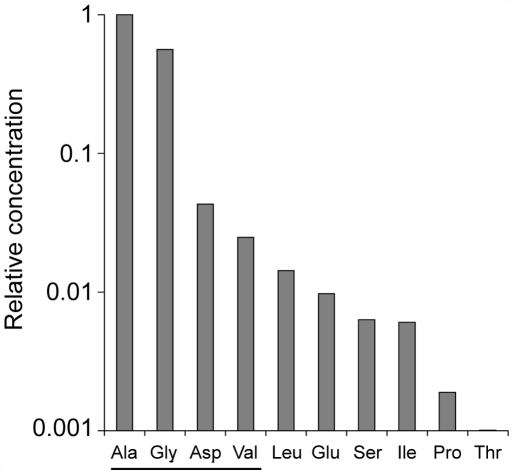
Relative abundance of primitive amino acids.Relative abundance of the 10 most frequent amino acids of the genetic code synthesized in an experiment thought to reproduce the conditions of the prebiotic Earth. Graph established from the data of Table 3 in ref. [11].